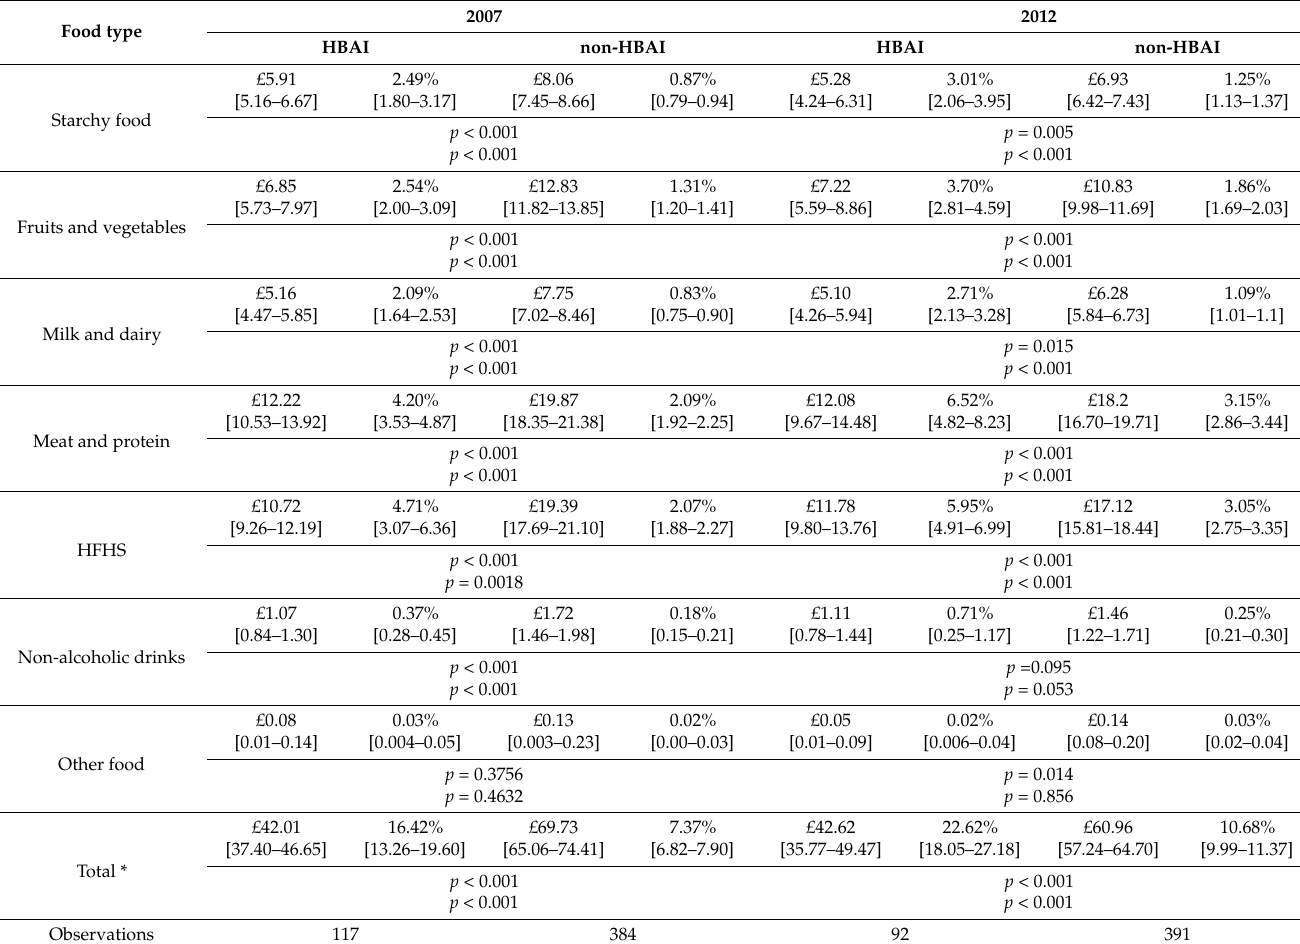
Table 2. Mean weekly expenditure * (£ and % of income) of HBAI (households below average income.) and non-HBAI, by food